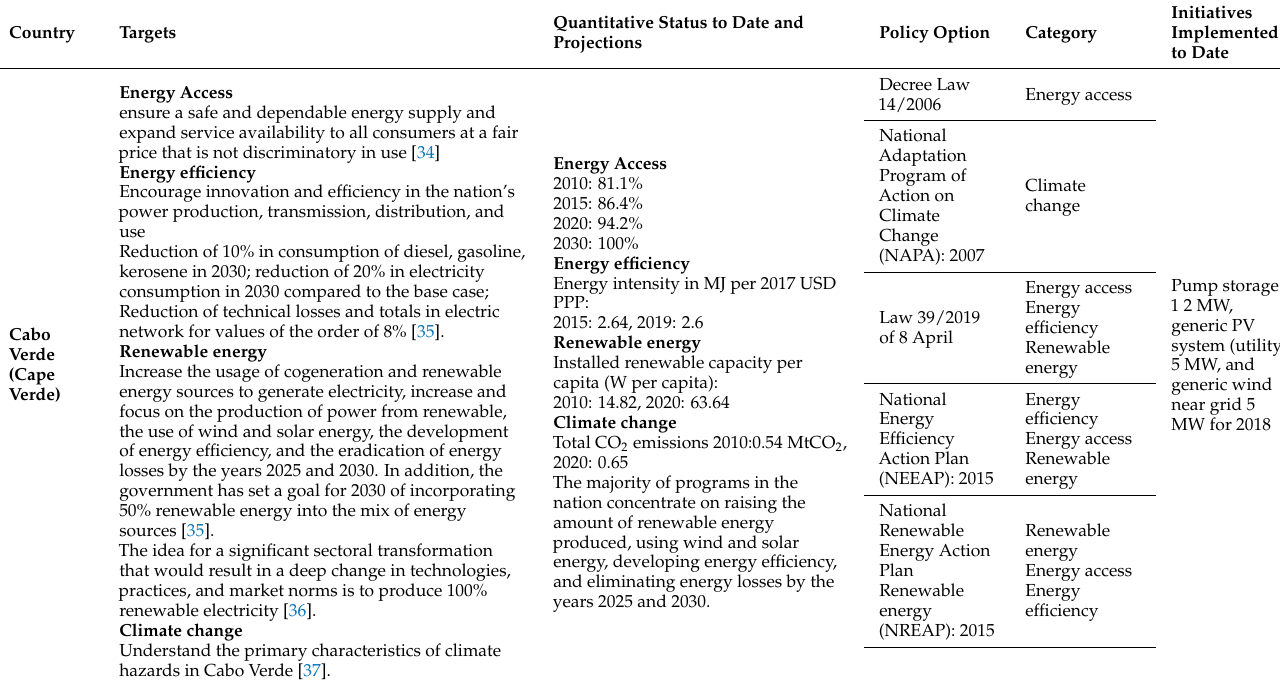
Table 3. Cape Verde (data from